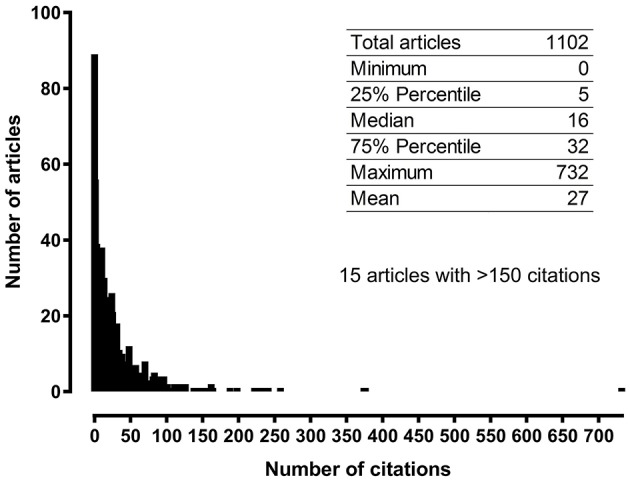
Frequency histogram showing the number of citations of Sigma-1 receptor articles published between 1992 and 2017.